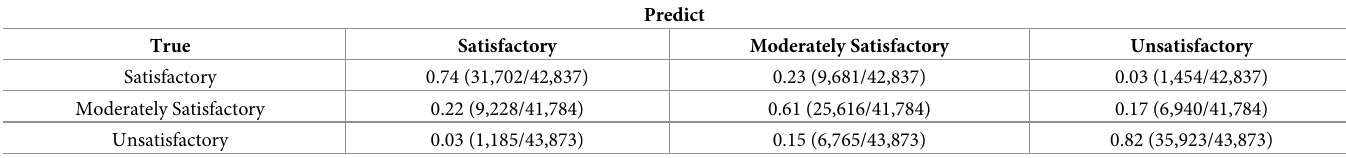
Table 3. Normalized confusion matrix for stationary